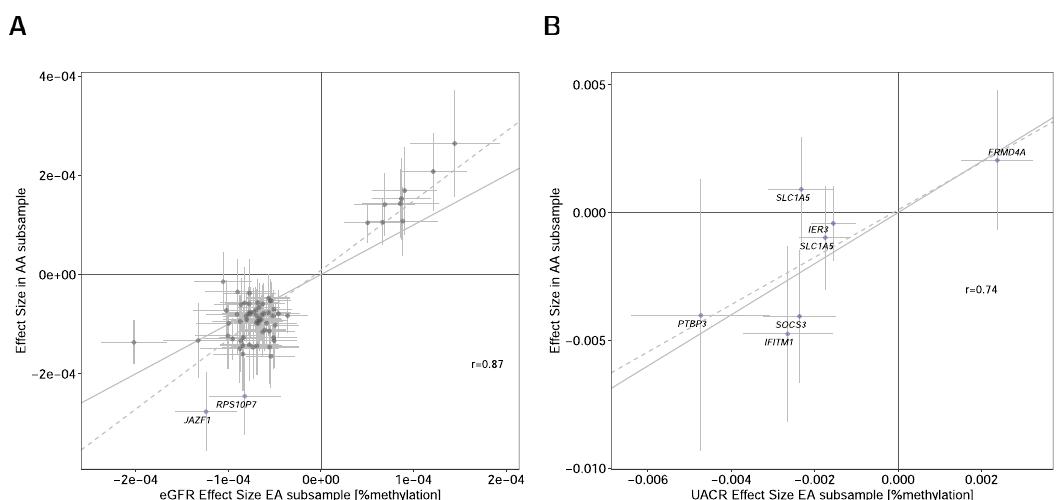
Fig. 2 Similar effects between EA and AA-speci fi c analyses. Comparison of effect estimates of the association Wald-test of the signi fi cantly associated CpG sites (CpGs) for estimated glomerular fi ltration rate (eGFR) ( A ) and urinary albumin-to-creatinine ratio (UACR) ( B ). The effects in the European ancestry (EA) meta-analysis epigenome-wide association study ( x -axis) ( n eGFR = 23,671; n UACR = 9806) are compared with the corresponding effect sizes of the African American ancestry (AA) subsample ( y -axis) ( n eGFR = 5019; n UACR = 1921). In panel ( A ), sites that showed a signi fi cant P -value of the two- sided t -test for ancestry heterogeneity ( P -value < 0.05/69) are colored in blue and labeled with the closest gene name. In all panels, the dashed gray line represents the linear regression slope between the dots, the solid gray line shows the diagonal, error bars indicate 95% CIs, and the Pearson correlation coef fi cient r between the effect estimates is